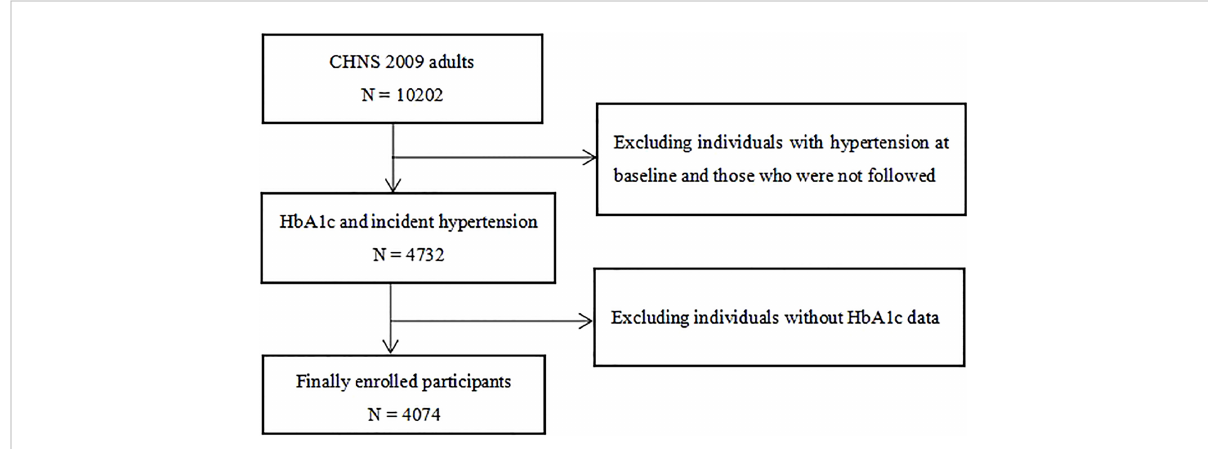
FIGURE 1 Flow chart of the study population. CHNS, China Health and Nutrition Survey; HbA1c, hemoglobin